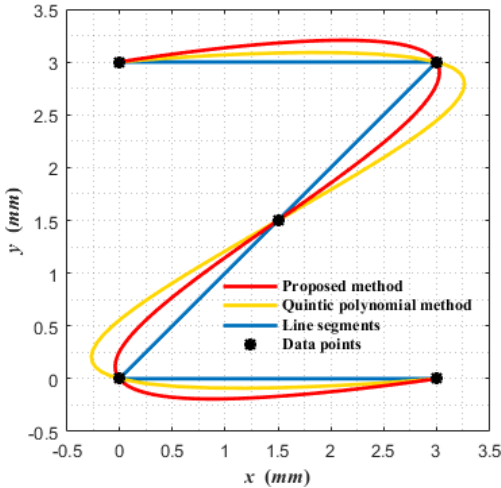
Figure 4. Letter Z-shaped path and synthesized